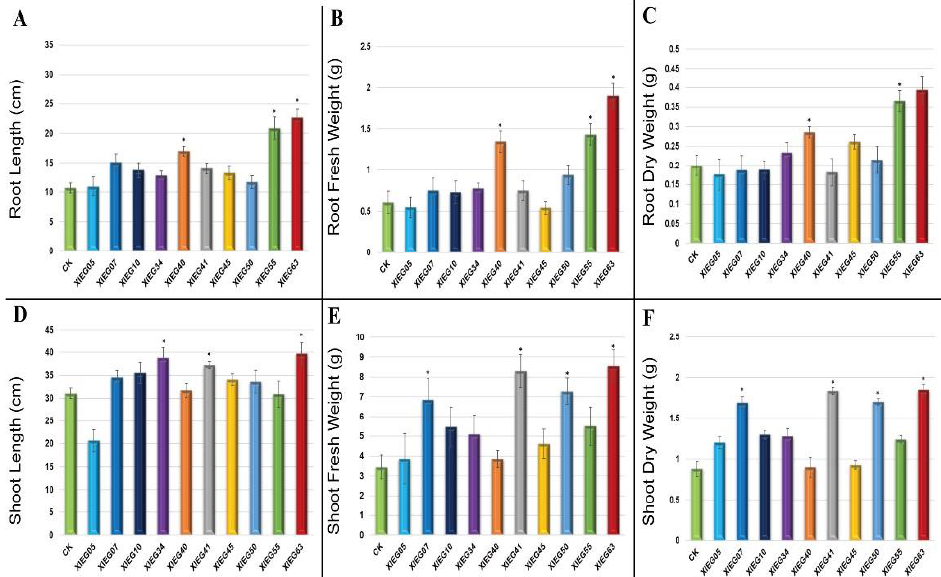
Figure 4. The growth parameters of cotton 60 days after inoculation with the selected endophytic actinobacteria compared with an uninoculated control plant. The data represent a mean of 10 – 12 replicates ± standard error (SE). The columns marked by ( “ * ” ) indicate significant differences based on one-way ANOVA, followed by Tukey ’ s HSD post hoc test for multiple comparisons at alpha level = 0.05. ( A ) Root length; ( B ) Root fresh weight; ( C ) Root dry weight; ( D ) Shoot length; ( E ) Shoot fresh weight; ( F ) Shoot dry weight.